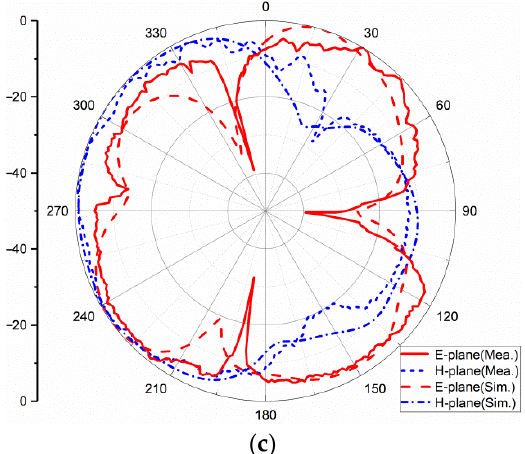
Figure 14. Radiation pattern at: ( a ) 3.5 GHz; ( b ) 7 GHz; ( c ) 10 GHz.